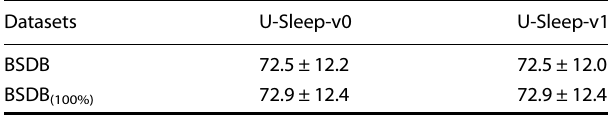
Table 2. (i) Clinically non-recommended channel derivations.